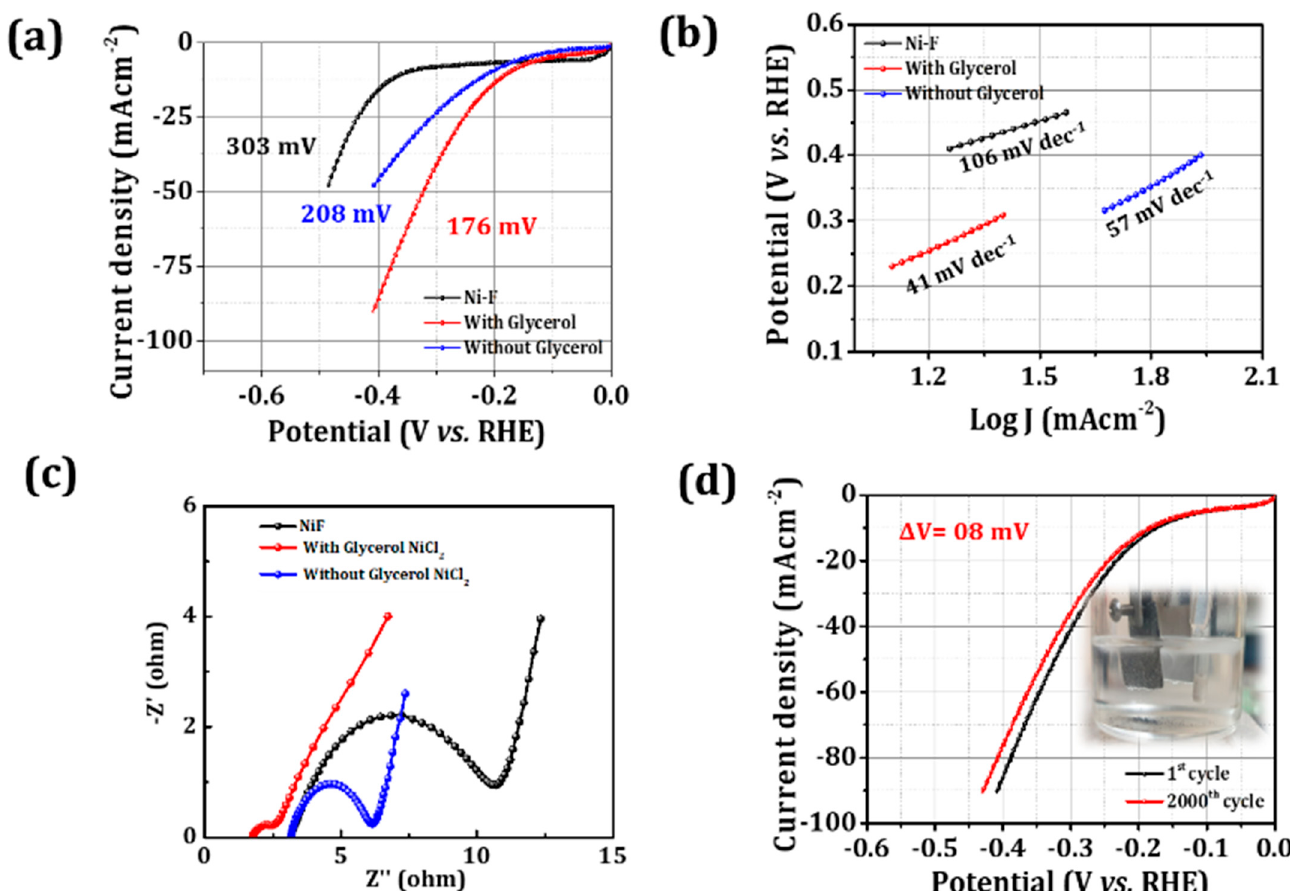
Figure 3. ( a ) HER polarization curves, ( b ) Tafel plots, and ( c ) EIS spectroscopy measurements of NiF and NiCl 2 (with and without glycerol) electrode materials. ( d ) Cyclic stability test (inset shows the real ‐ time image of H 2 evolution reaction) of dandelion flower ‐ type NiCl 2 .